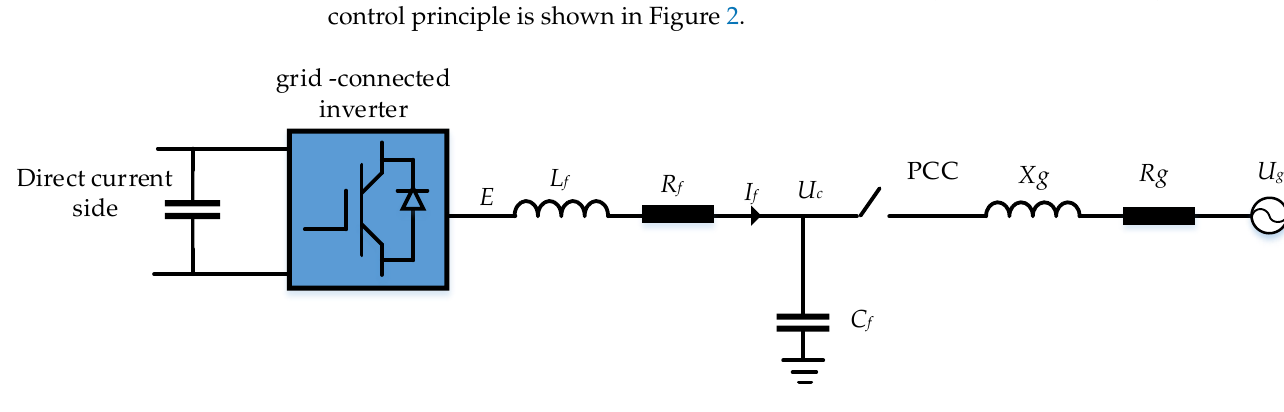
Figure 1. Circuit diagram of the grid-connected inverter.